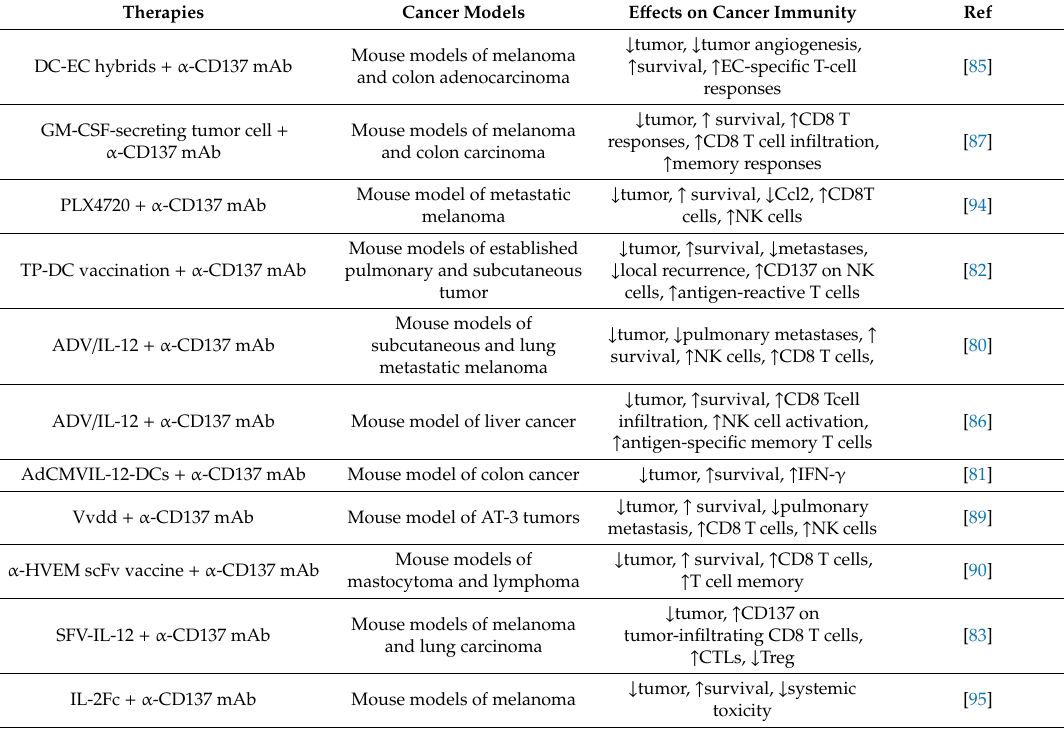
Table 4. The e ff ect of anti-CD137 and other combinations on tumor immunity. Therapies Cancer